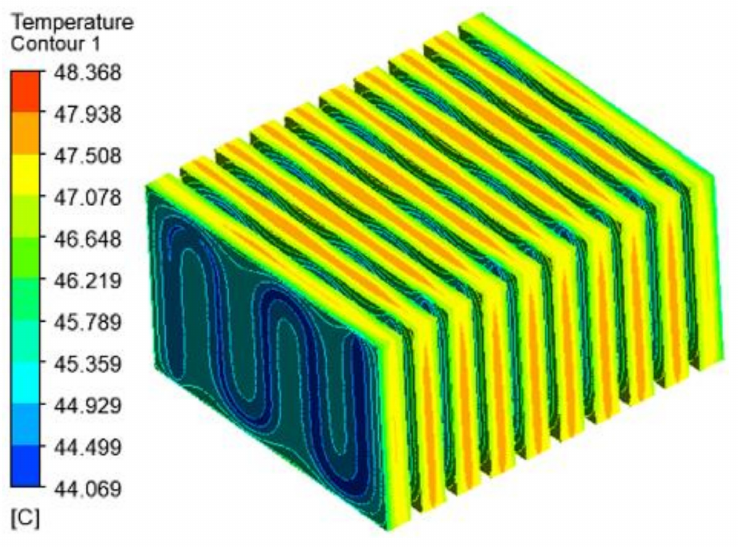
Figure 9. Temperature distribution contours of Candidate Combination